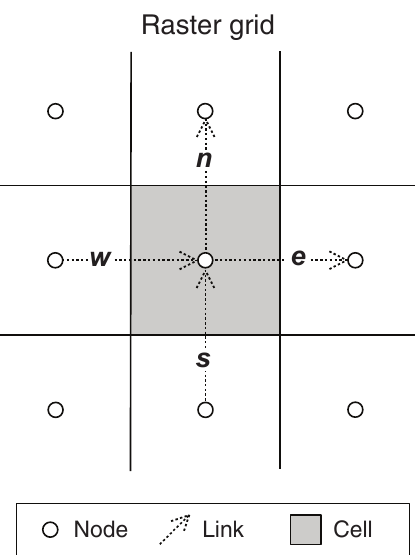
Figure 3. Example of the Landlab structured grid type with key topological elements shown. In the Landlab OverlandFlow compo- nent, RasterModelGrid class stores data at both nodes and links. Links denoted as west ( w ) and south ( s ) are called “inlinks”, while north ( n ) and east ( e ) are “outlinks” of the center node. Direction is only for topological reference; flux directionality is tied to gradients on the grid.